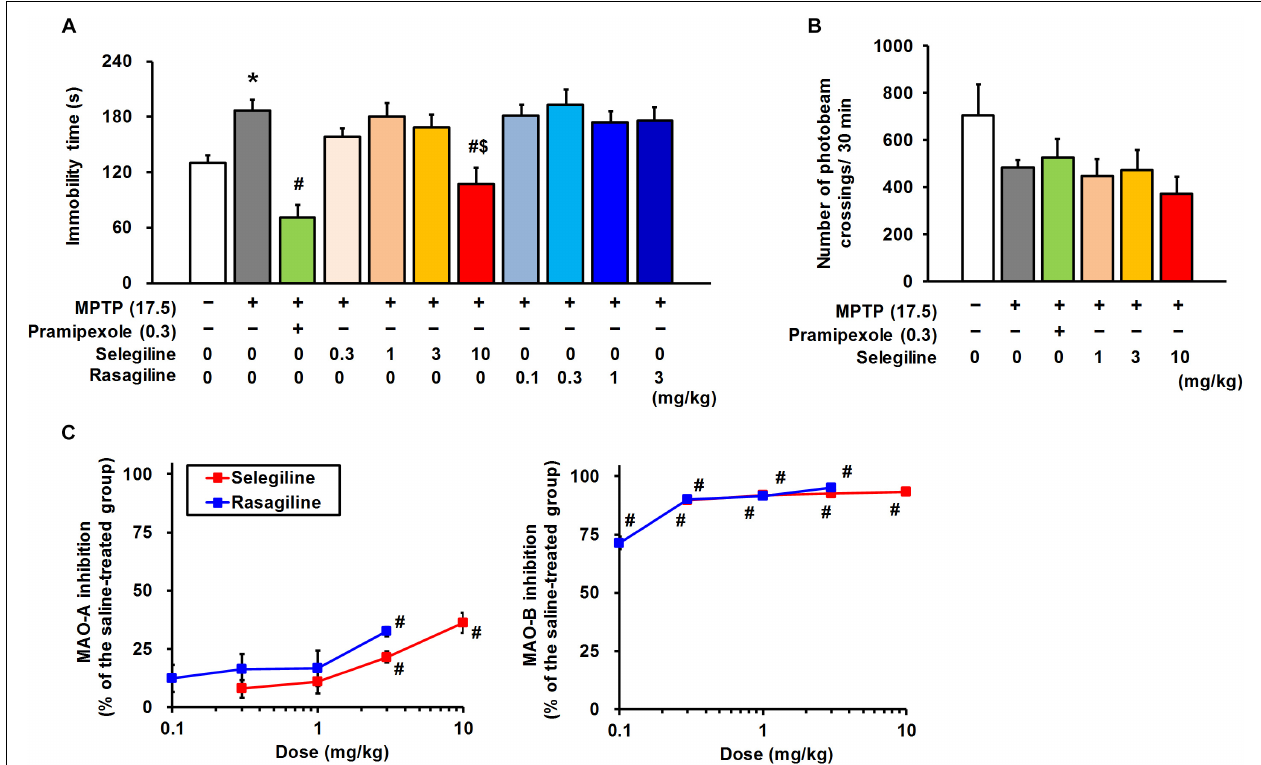
FIGURE 2 | Effects of monoamine oxidase-B inhibitors, selegiline (SEL) and rasagiline (RAS), and pramipexole (PRX) on depression-like behavior in MPTP mice. (A) Administration of SEL or PRX, but not RAS, ameliorated the depression-like behavior of MPTP mice. The groups were control ( n = 11), MPTP + saline ( n =